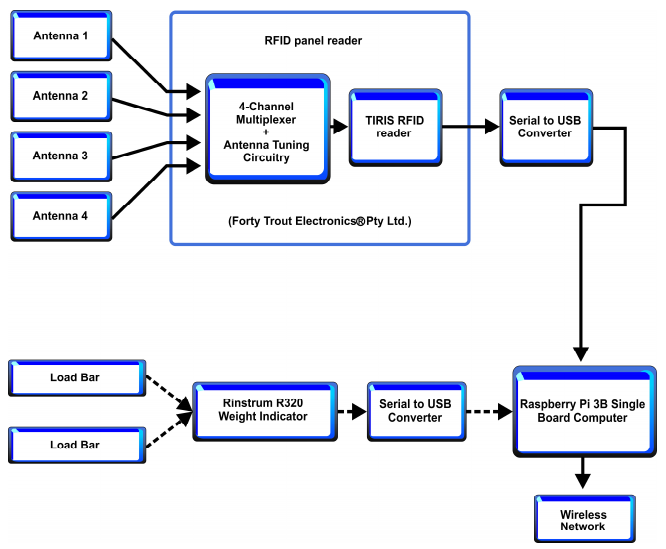
Figure 3. Schematic of the automatic supplement weighing (ASW) unit